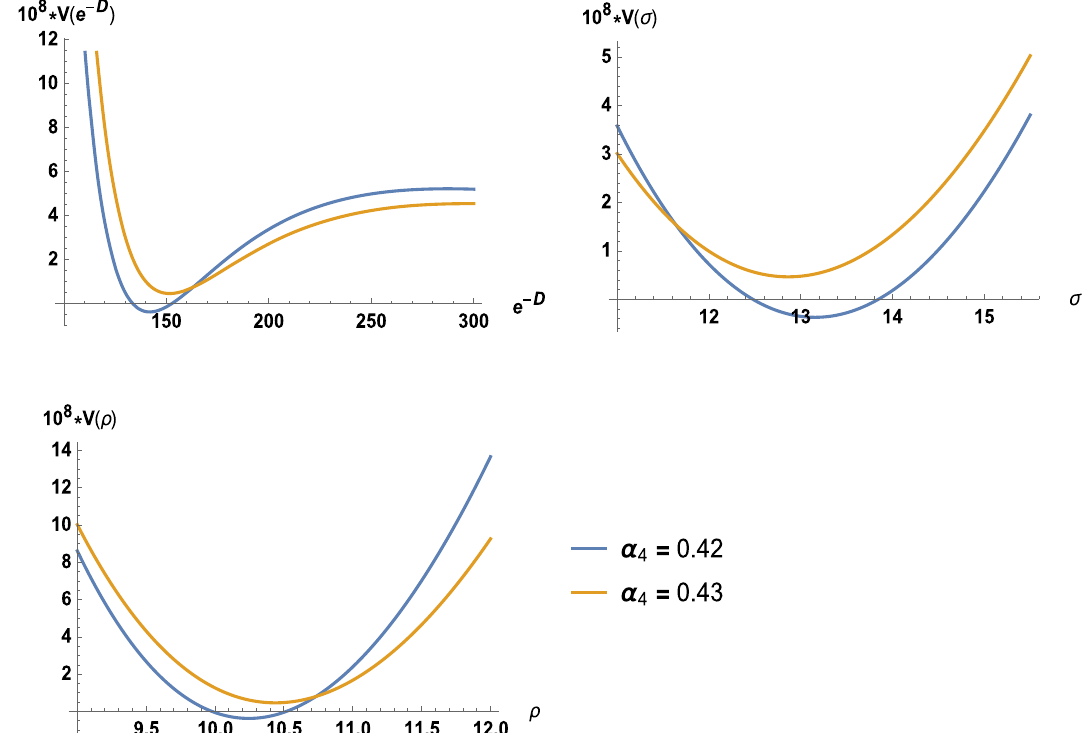
Fig. 1 One dimensional slices of scalar potential showing AdS to dS uplifting by α 4